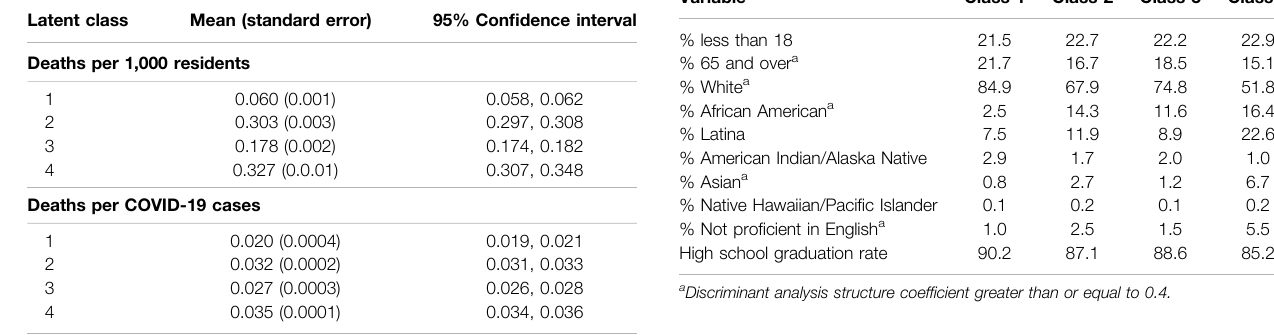
TABLE 3 | Mean (standard error) of deaths/1,000 residents and deaths per number of cases by latent class.